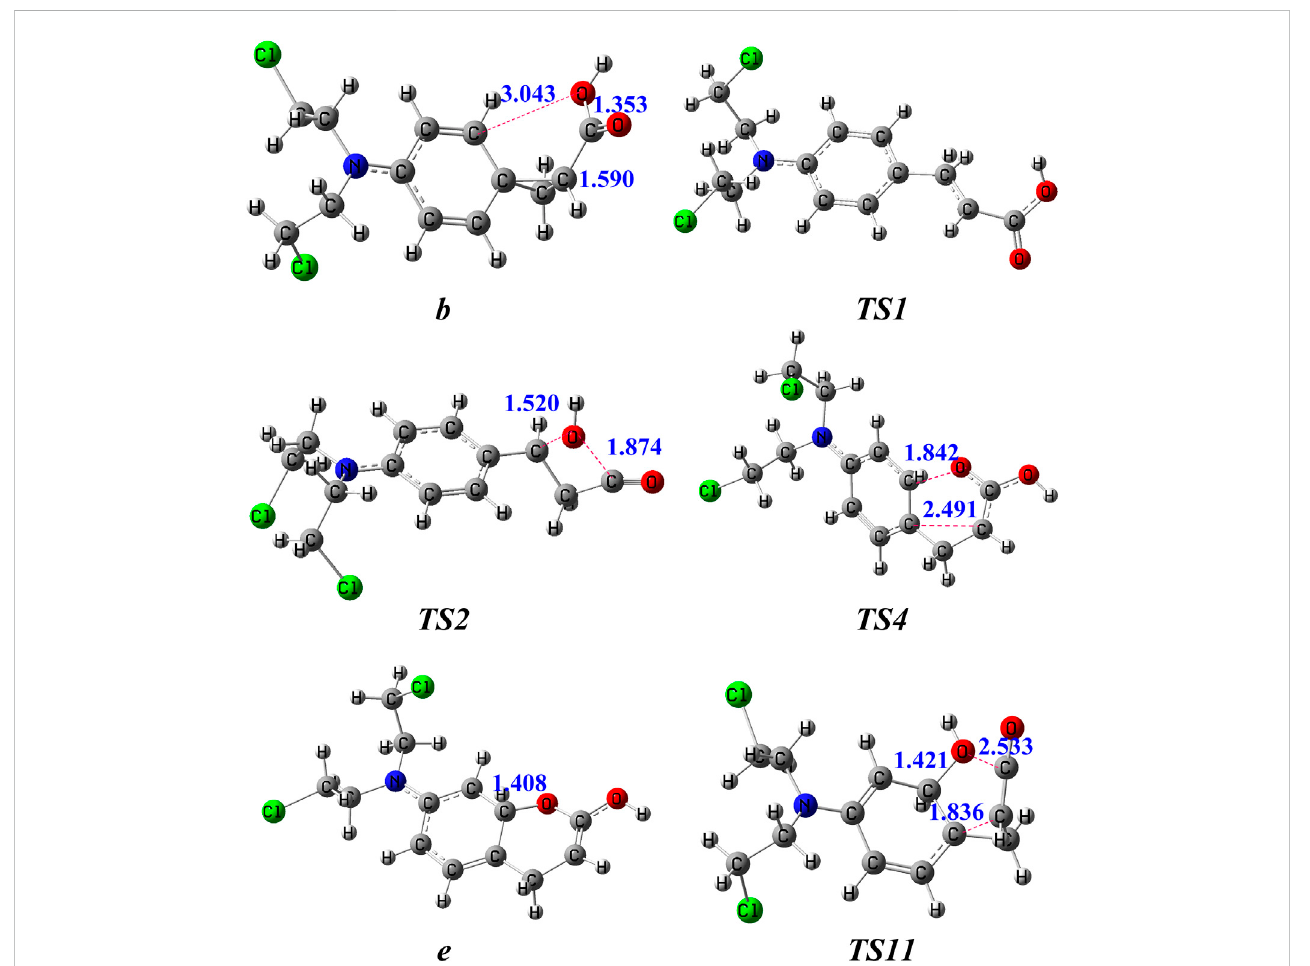
FIGURE 3 The optimized structures of key intermediates for the generation of m/z 246 in the dissociation of [melphalan + H – NH 3 ] + at the B3LYP/6-31+G (d, p ) level. The bond lengths are given in Å.